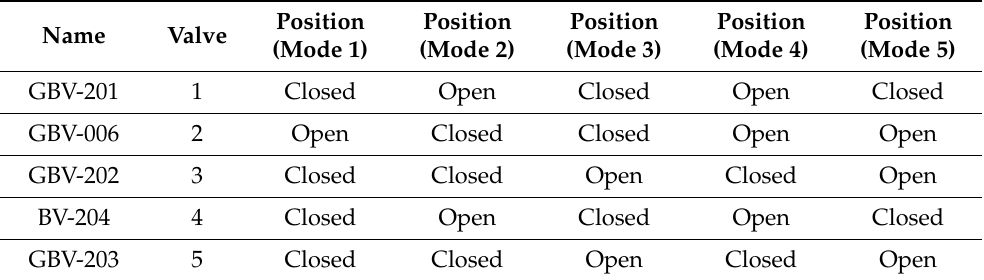
Table 4. Valve positioning in